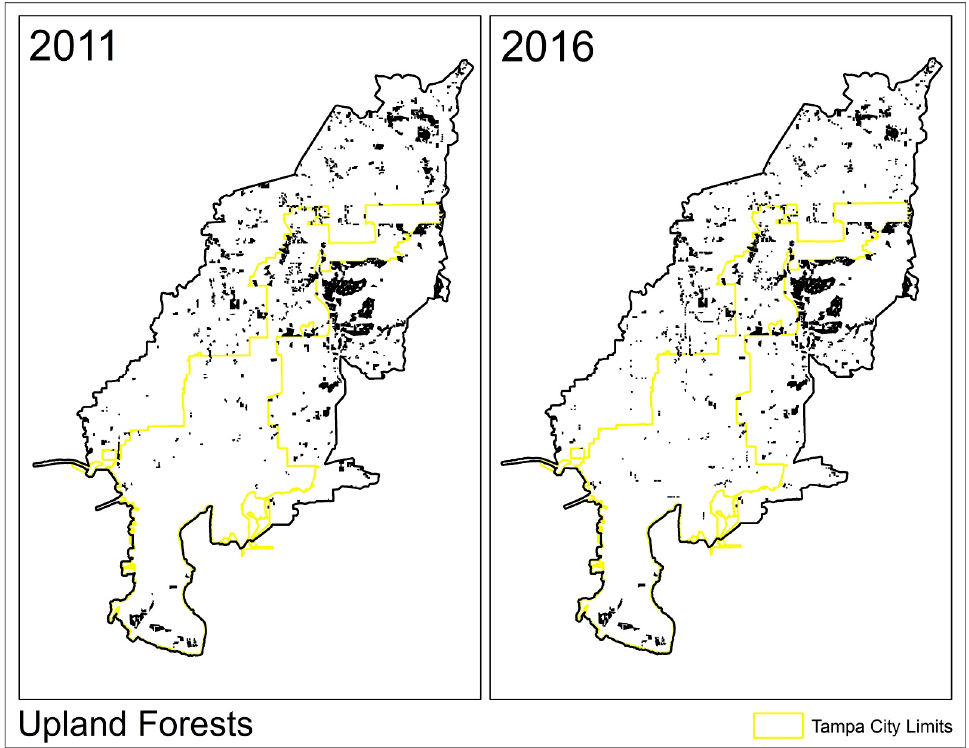
Figure A8. Observed (2011) and Modeled (2016) LULC distribution for the “Upland Forests” class.